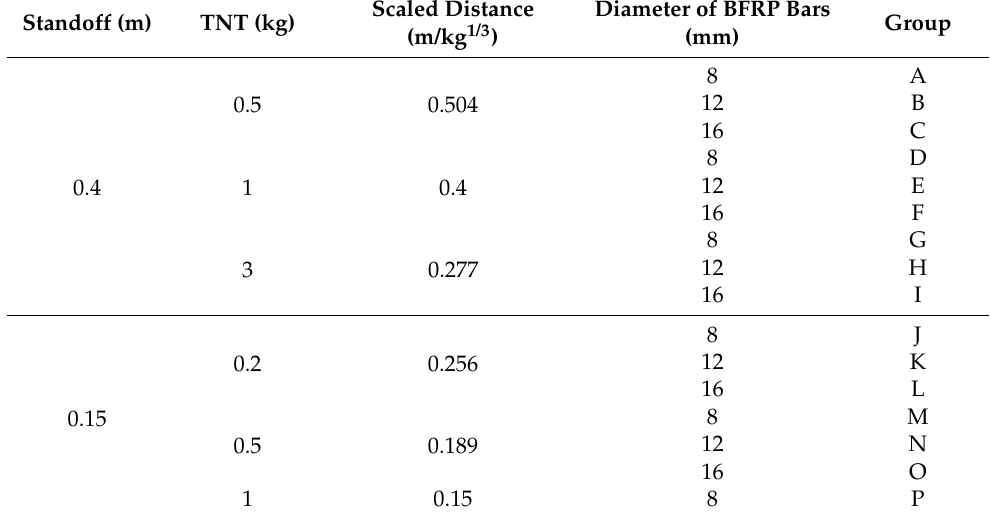
Table 6. Multi-condition